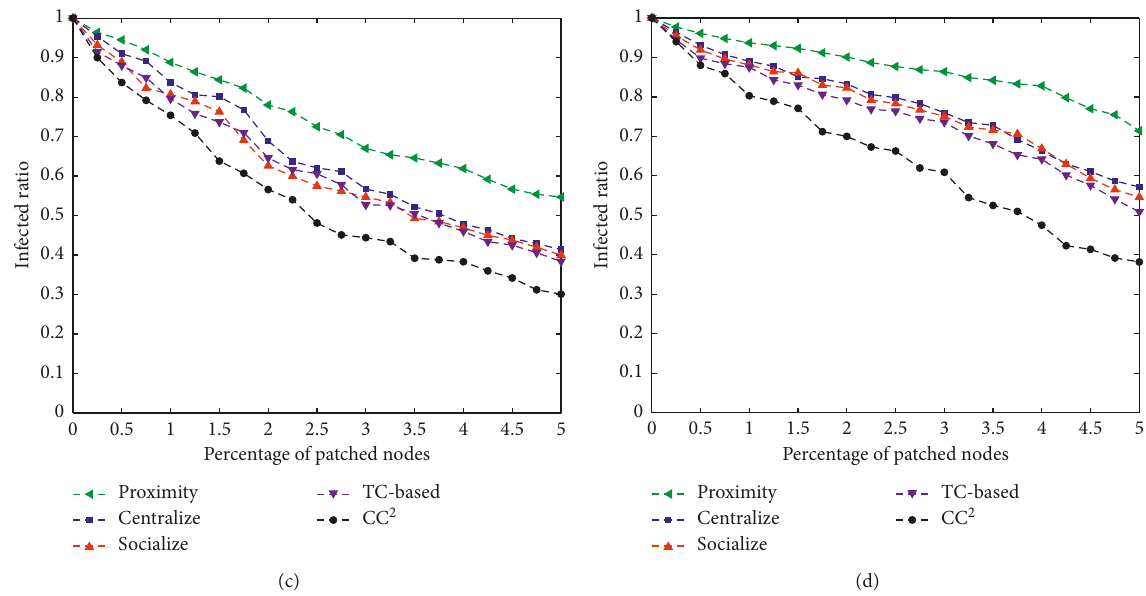
Figure 11: Performance comparison of different patching strategy on the MIT Reality network with an initially infected ratio μ � 5% (a), 10% (b), 15% (c), and 20% (d), respectively.